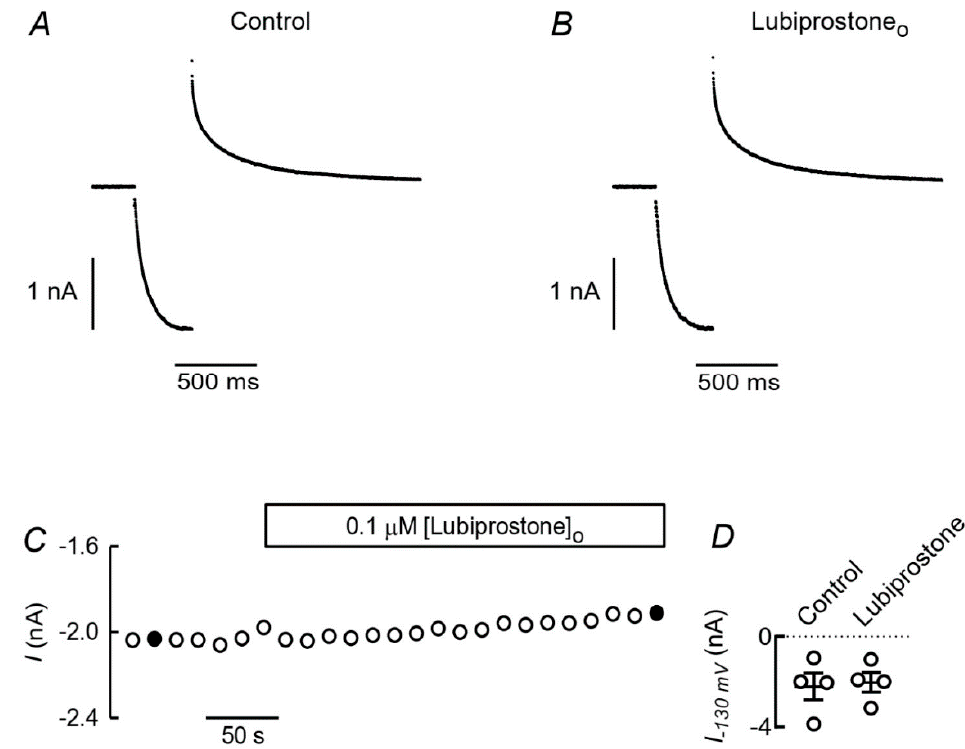
Figure 5. E ff ect of extracellular lubiprostone on ClC-2 currents. Whole cell currents measured in HEK-293 cells transfected with ClC-2. Traces in ( A ) and ( B ) were elicited from a V h of − 30 mV by test pulses to − 130 followed by a step to 30mV and correspond to a control current and one taken after addition of 0.1 µ M lubiprostone. Extra- and intracellular solutions were respectively 146 and 35 mM Cl − . They are part of a train of identical pulses given with a 15 s period. The complete experiment is reported in ( C ) through the steady state currents at the main activating pulse. In black the pulses illustrated in ( A ) and ( B ). ( D ): the e ff ect of lubiprostone in separate individual experiments.